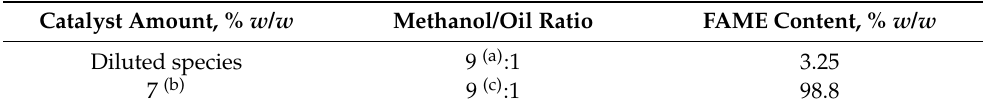
Table 2. Lixiviation tests for NaNO 3 /SiAl 20/1. Experimental conditions: temperature, 65 °C; reaction time, 180 min; stirring rate, 700 rpm.